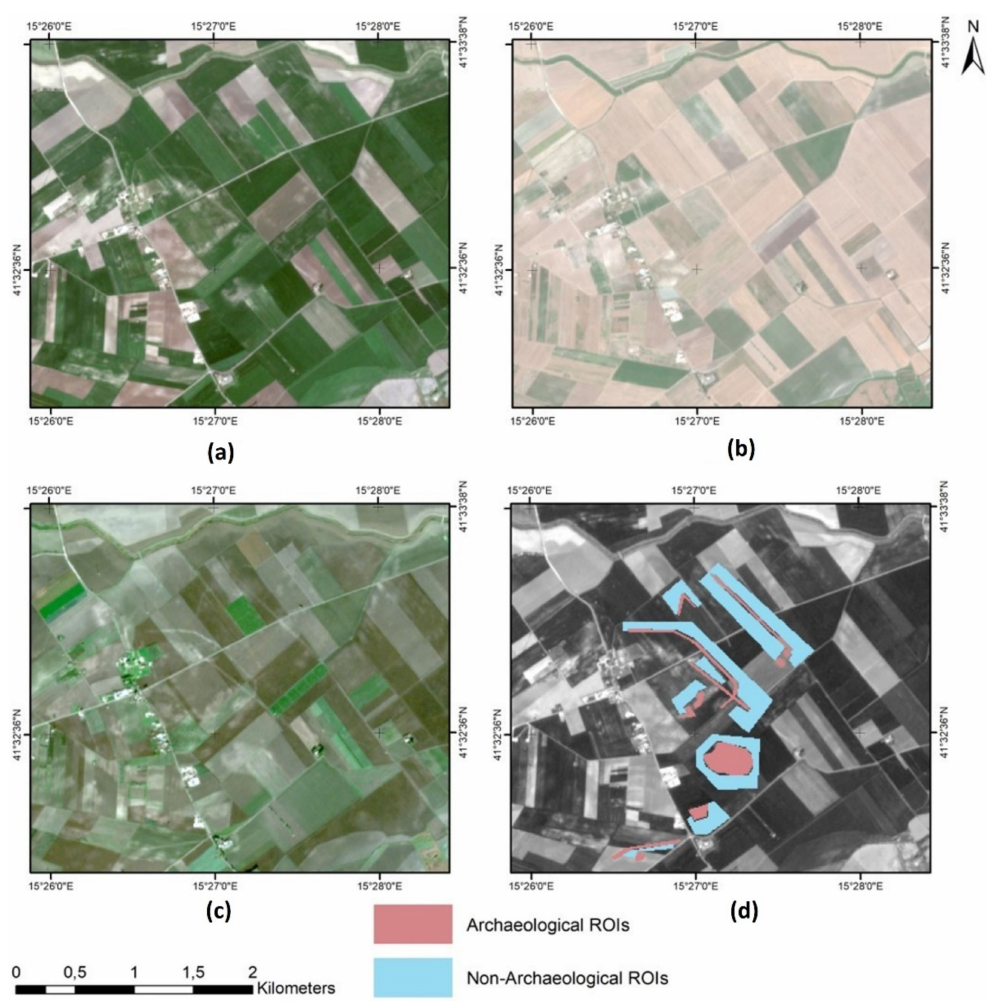
Figure 4. ( a ) Sentinel-2 RGB (2017-03-29); ( b ) Sentinel-2 RGB (2018-07-02); ( c ) Sentinel-2 RGB (2018-12-09); ( d ) e.g., region of interest